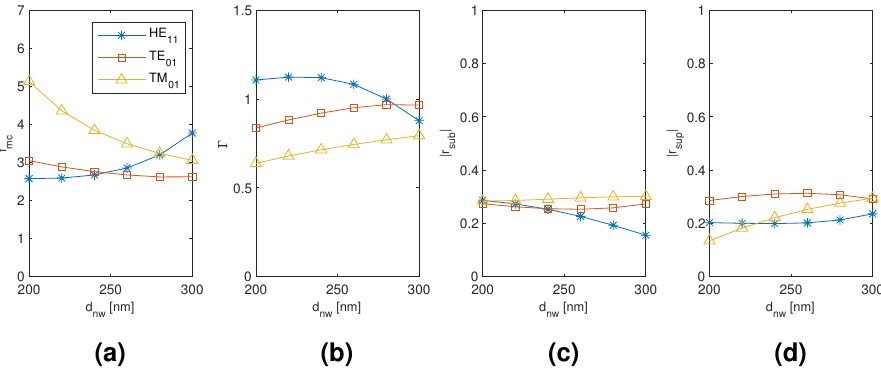
Figure 10. The results for the coated monomer HE 11 , TE 01 , and TM 01 mode as a function of the nanowire diameter with the coating thickness corresponding to the point of modal cost function minimum for each mode (as listed in Table 2). ( a ) modal cost function value; ( b ) modal confinement factor; ( c ) substrate modal reflection coefficient magnitude; ( d ) superstrate modal reflection coefficient magnitude.